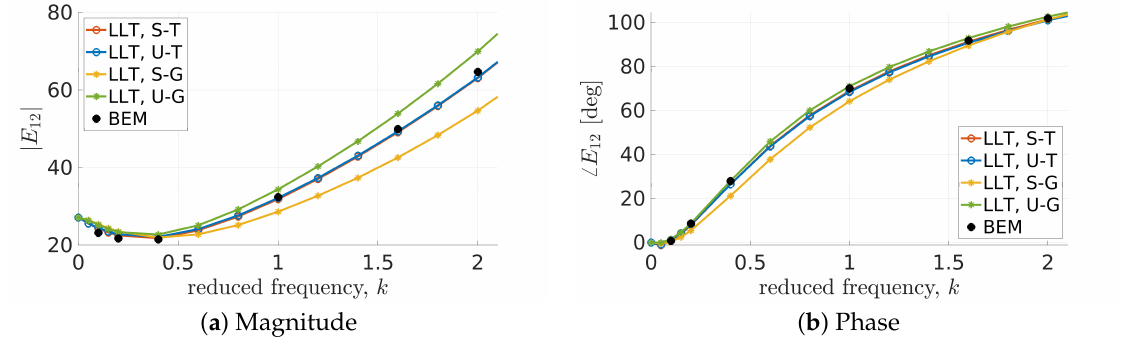
Figure 2. Transfer function E 12 ( k ) , constant shape functions, l = 5m.